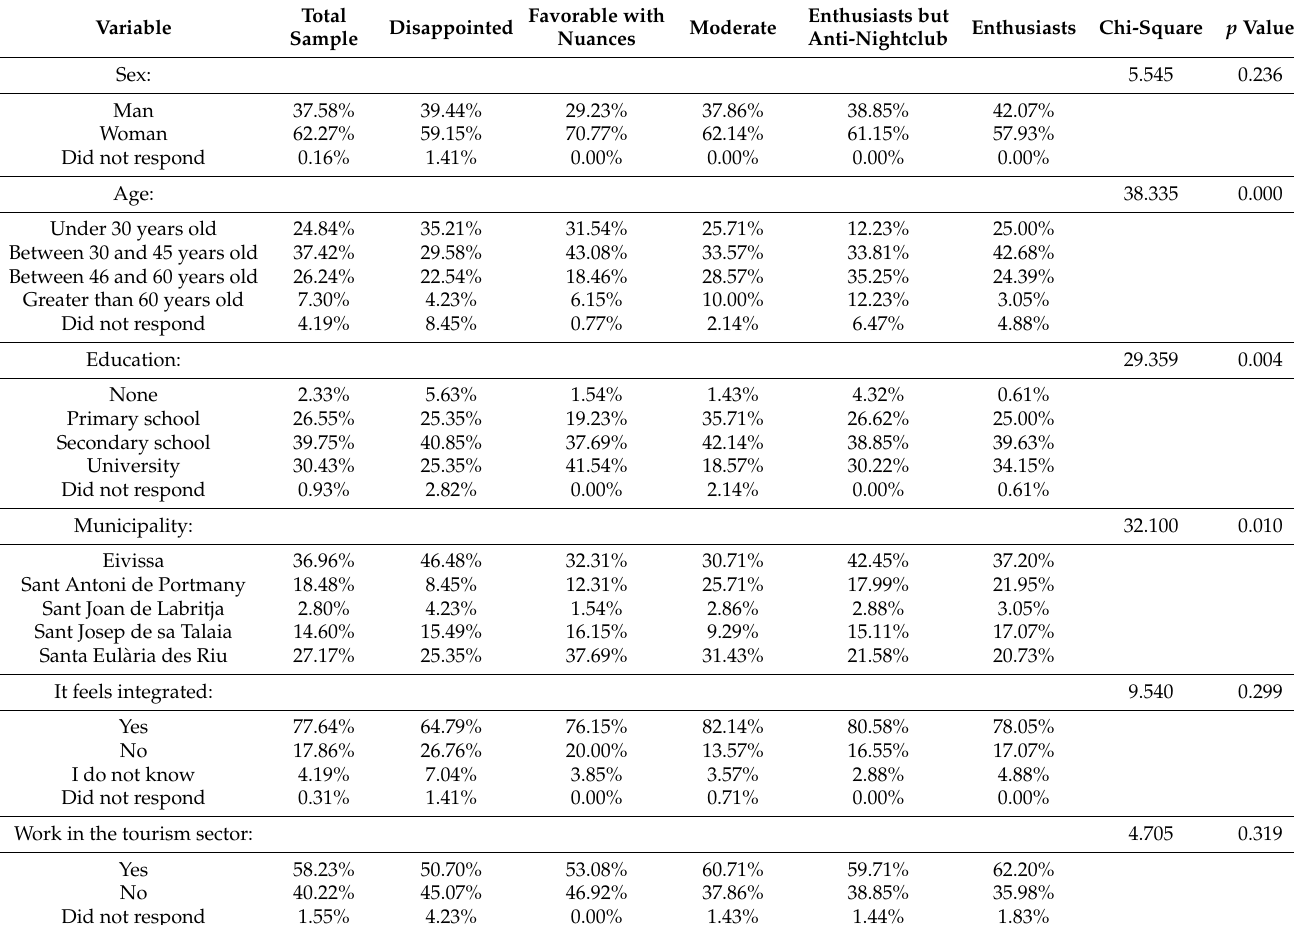
Table 4. Sociodemographic profile of the conserved clusters (own